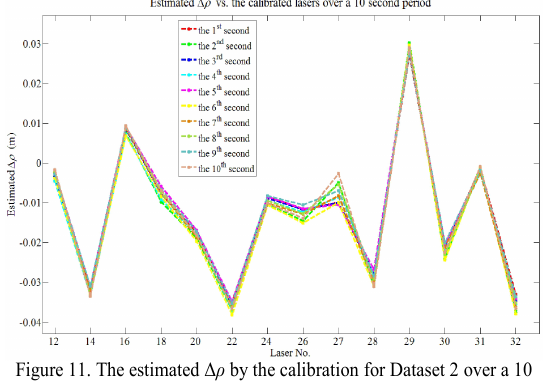
Figure 11. The estimated Δ ρ by the calibration for Dataset 2 over a 10 second